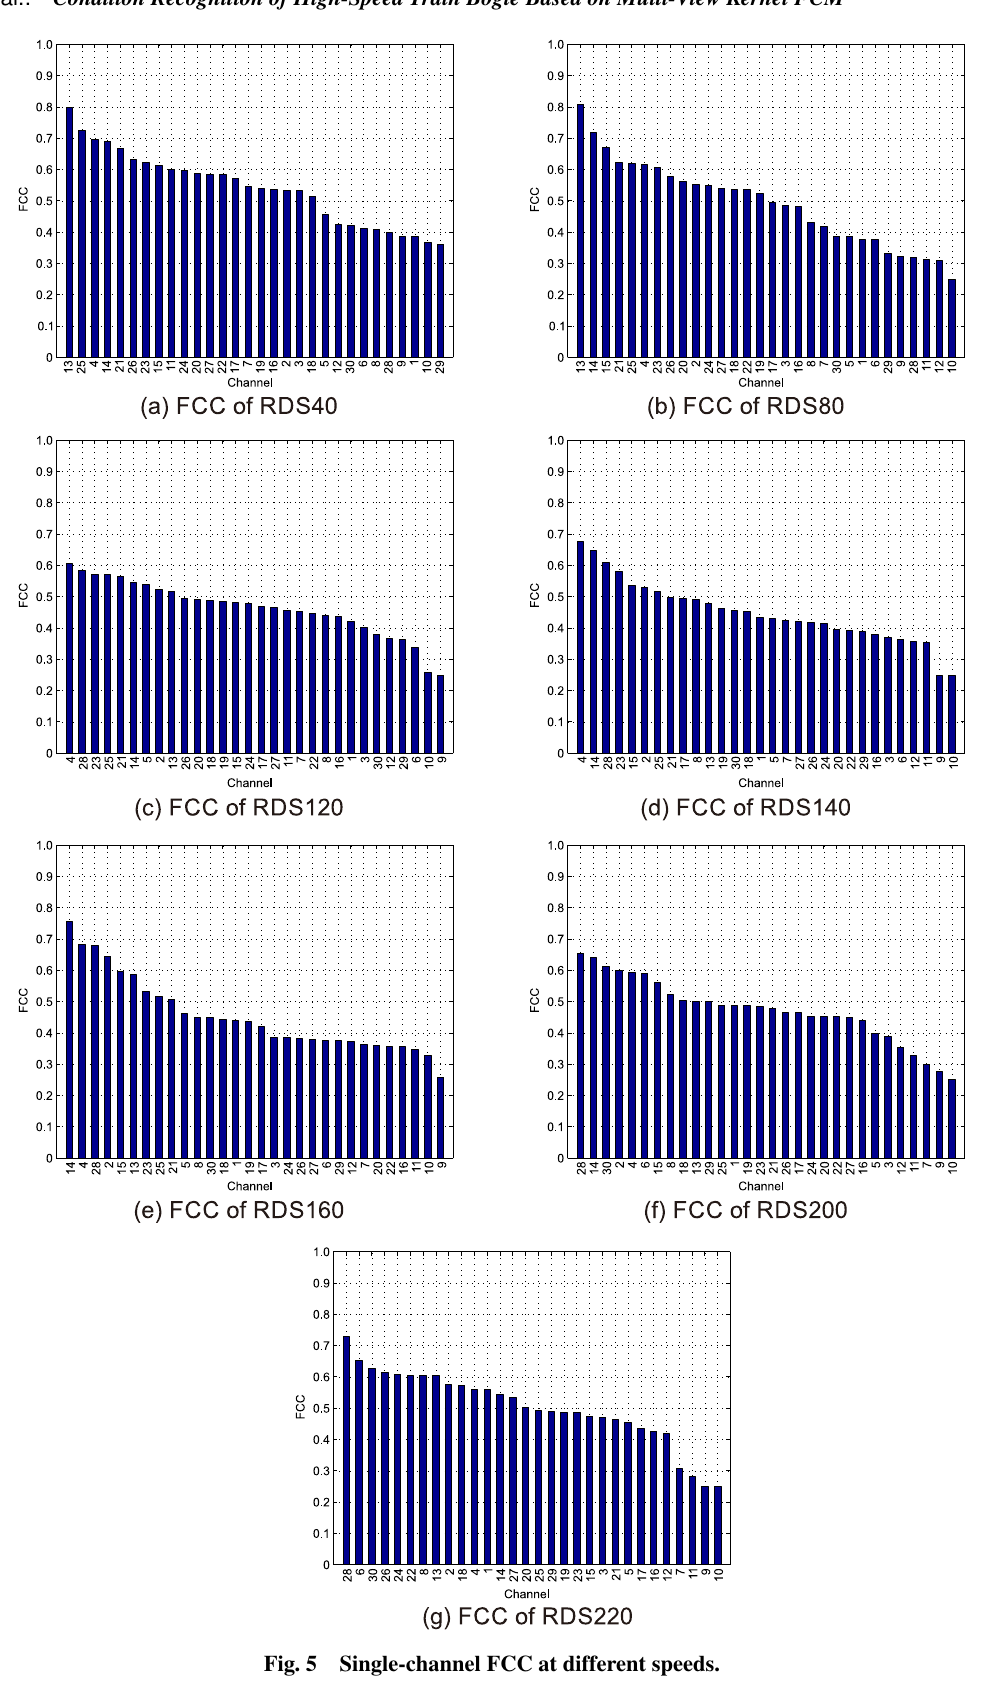
Fig. 5 Single-channel FCC at different